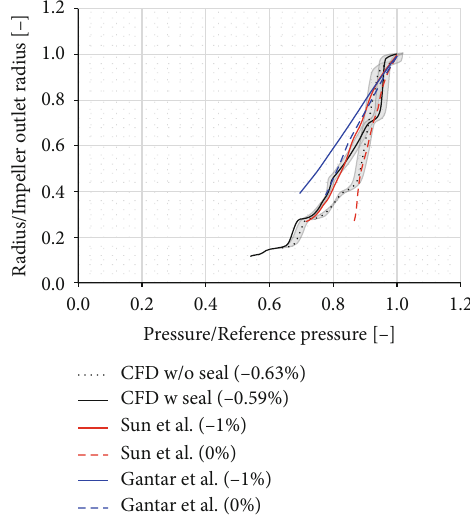
Table 7: Comparison of measured and modeled total-to-total pressure ratio without and with the labyrinth seal. Figure 6: Numerical results of pressure distribution on the back disk side without and with the labyrinth seal. Gray areas present Without seal With seal the discretization error, and relative leakage fl ow rate is shown in Exp. Point parentheses in the legend. Numerical results are compared with those presented in [3] and to the experimental results in